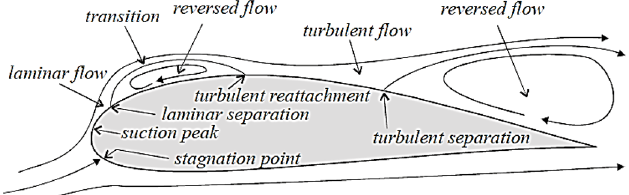
Fig. 2. Flow regimes within separation above aerofoil